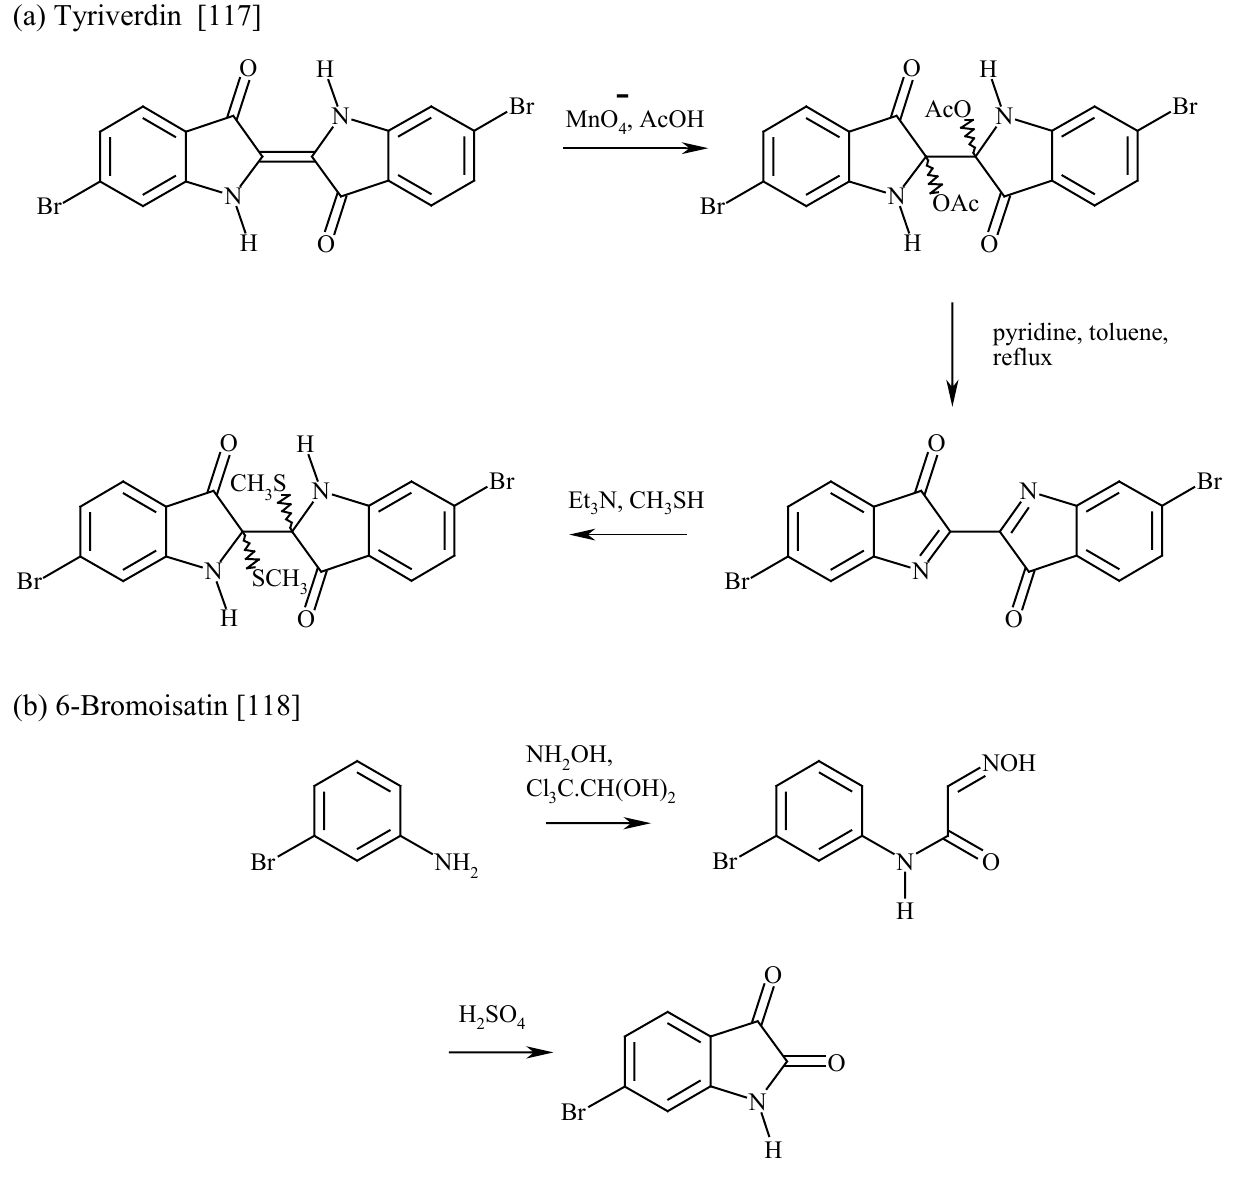
Figure 12 . The synthesis of the intermediates of the purple and the minor